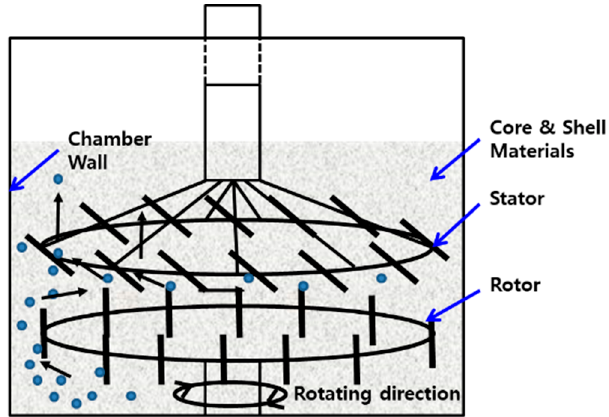
Figure 2. Schematic of the impellor structure of the dry process equipment (COMPOSI, brand name of Nippon Coke & Engineering’s super mixer) and the moving paths of particles.